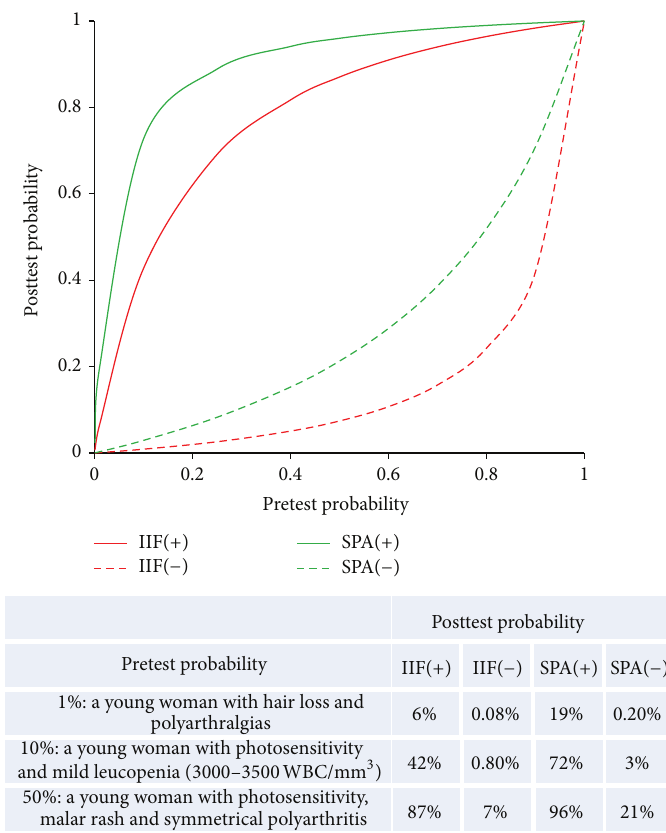
Figure 1: Illustration of pretest and posttest probability. Posttest probability (predictive value) for systemic lupus erythematosus as a function of pretest probability and as a function of indirect immunofluorescence (IIF) and solid phase assay (SPA) (EliA CTD screen, Thermo Fisher) test result. Values for likelihood ratios are from Bossuyt and Fieuws [31], WBC = white blood